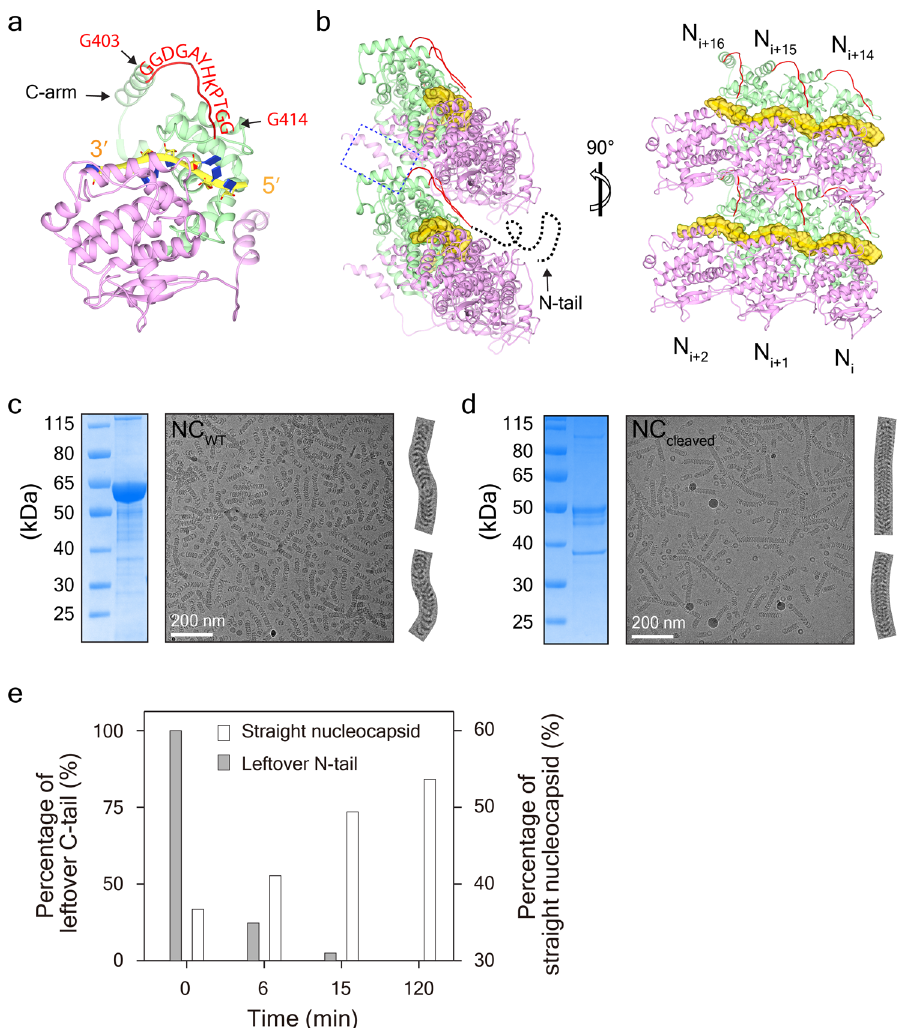
Fig. 3 N-tail correlates with nucleocapsid curvature. a The fi rst 12 residues (403 – 414) of N-tail are resolved in SeV NC cleaved . Loop 403 – 414 is colored in red and the residue names are labeled along the loop. b Different views of 6 protomers from two neighboring rungs are shown. The inner contact site between neighboring rungs is marked in a dashed blue box. The unidenti fi ed residues (415 – 525) are denoted as dotted curved lines. c Curved nucleocapsid formed by NC WT . Two typical curved fi laments are cut and zoomed in. d Straight nucleocapsid assembled by NC cleaved . Two typical straight fi laments are cut and zoomed in. e The straightening of nucleocapsid is tightly correlated to the removal of N-tail from SeV